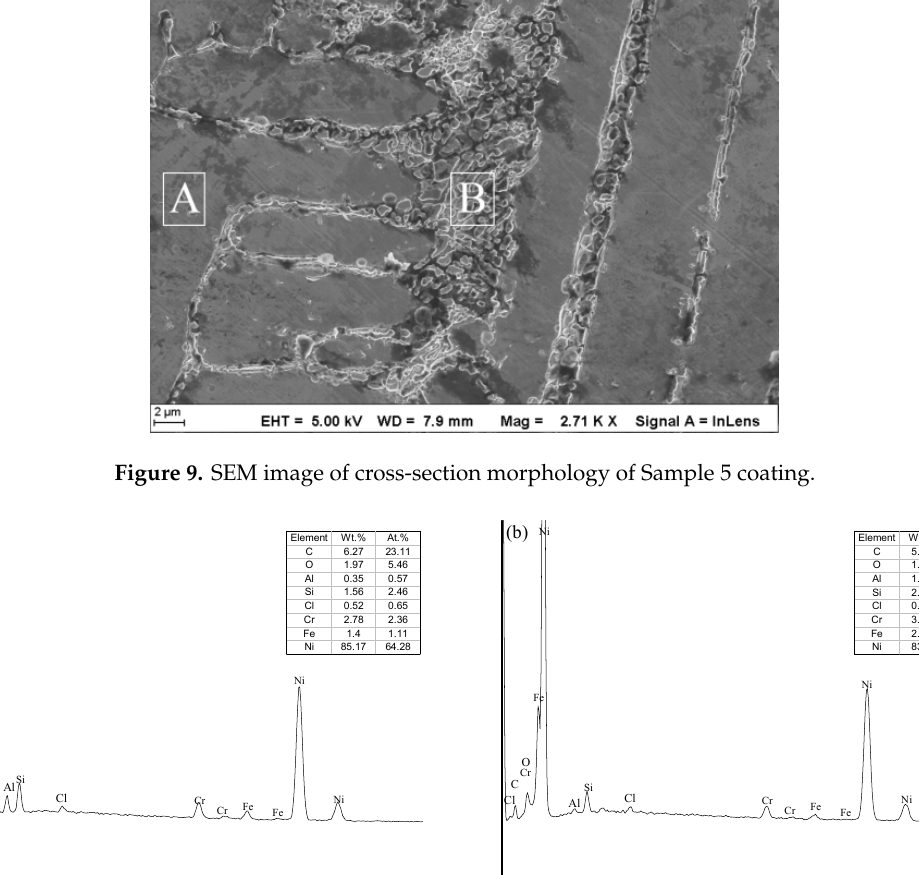
Figure 11. Diffraction patterns of 6 groups of single tracks.